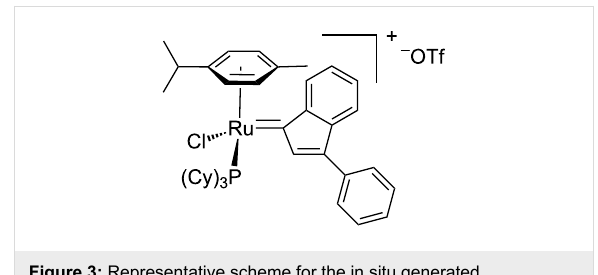
Figure 3: Representative scheme for the in situ generated Ru–indenylidene